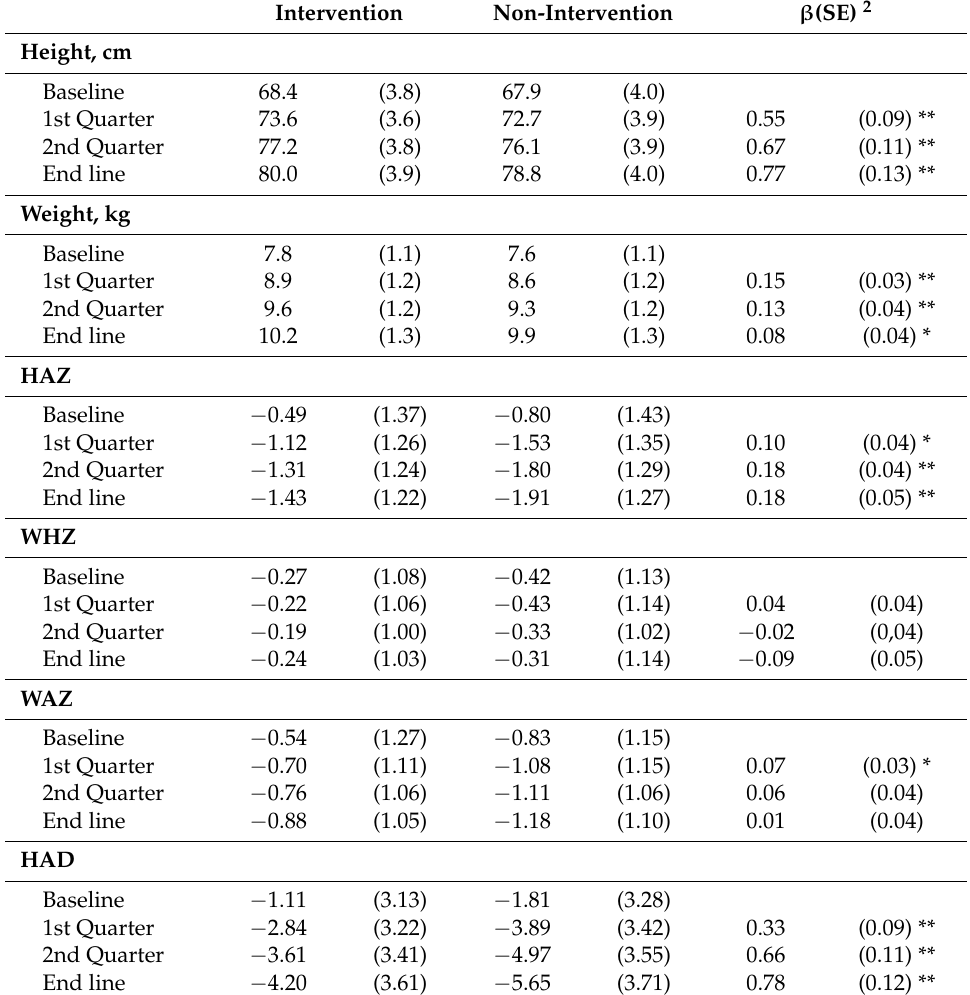
Table 5. Growth status of children during the intervention period